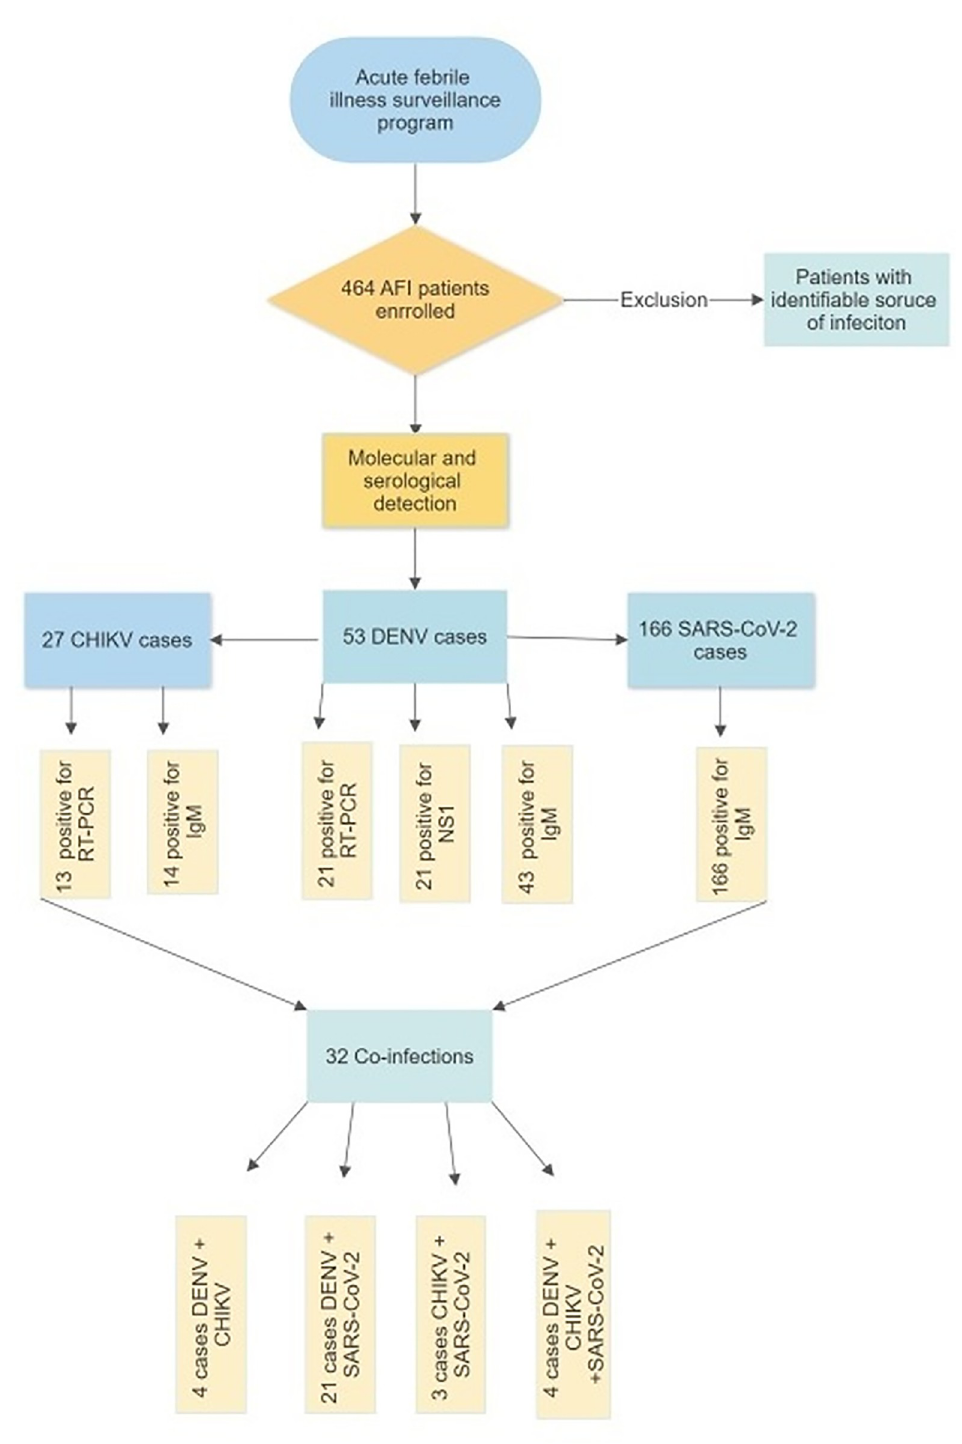
Fig 1. Flowchart of the research methods and study design.